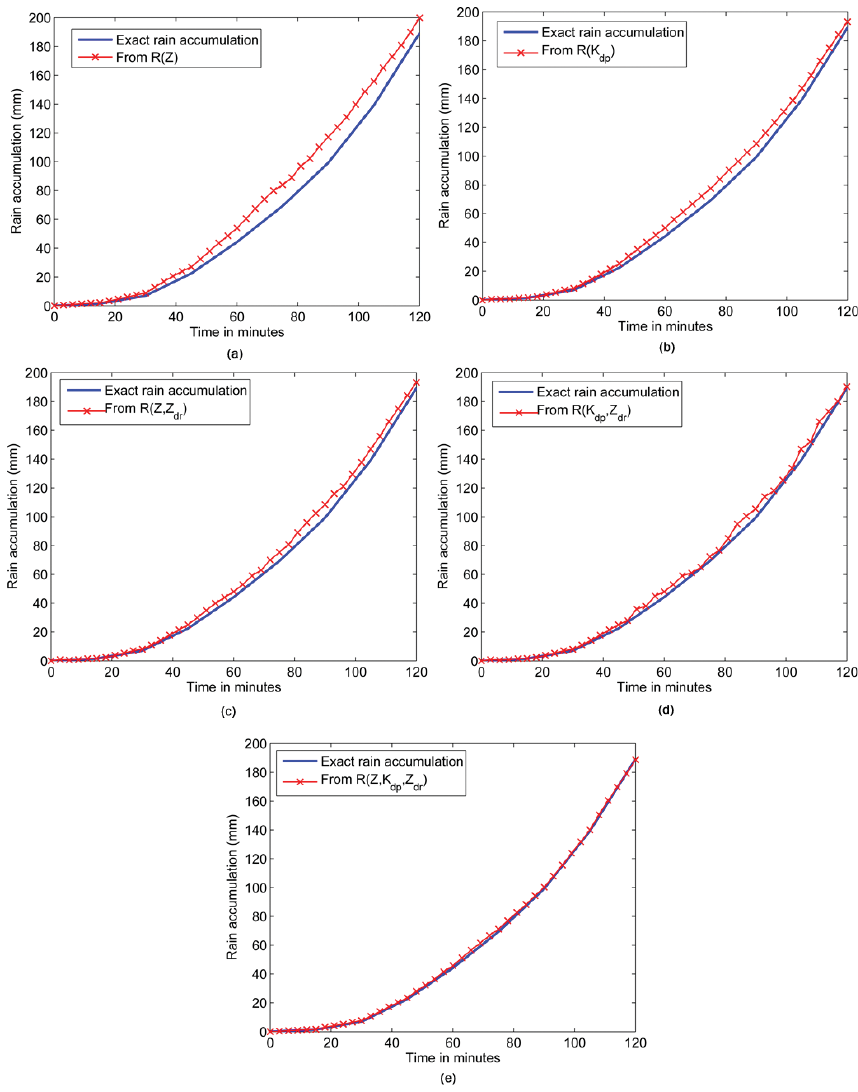
Fig. 5. Rain accumulation. (a) R(Z) , (b) R(K dp ) , (c) R(Z,Z dr ) , (d) R(K dp ,Z dr ) , (e) R(Z,K dp ,Z dr ) . Figure 7 Obtained biases for the physically-based rain rate estimation